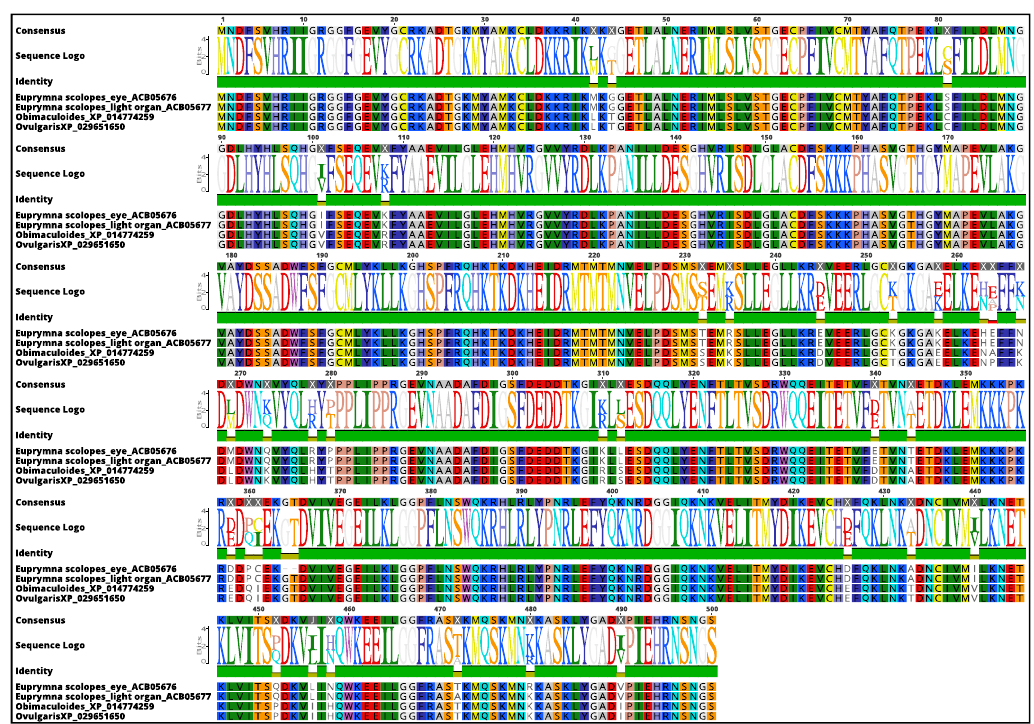
Figure 4. GRK1 amino acid sequences alignment. Alignment of Ov-GRK1 amino acid sequences to an O. bimaculoides rhodopsin kinase amino acid sequence from GenBank (accession number XP014774259) and to those of E. scolopes rhodopsin kinase extracted from the eyes (ACB05676) and light organ (ACB05677). White line boxes highlight potential amino acid differences among samples. Complete open reading frames are shown.